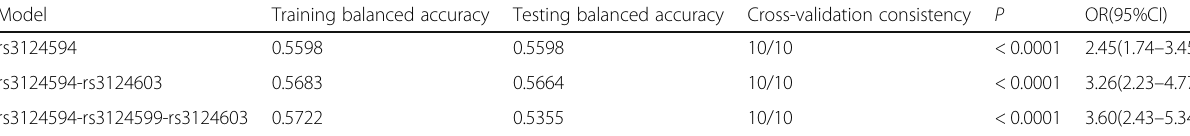
Table 6 MDR analysis results of the interaction between the three SNPs Model